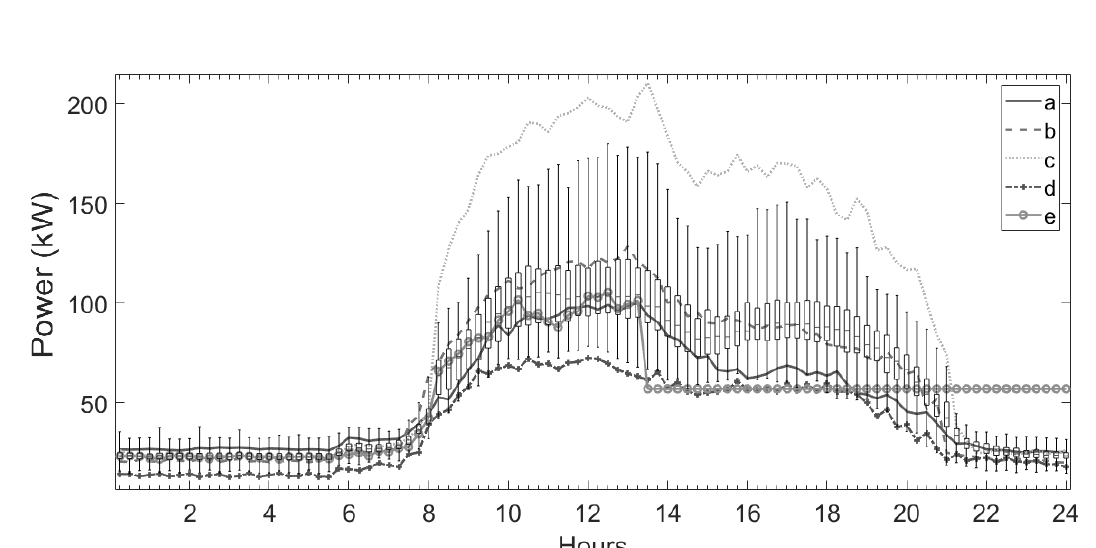
Figure 16. Anomalous electrical consumption profiles according to the without seasonal analysis